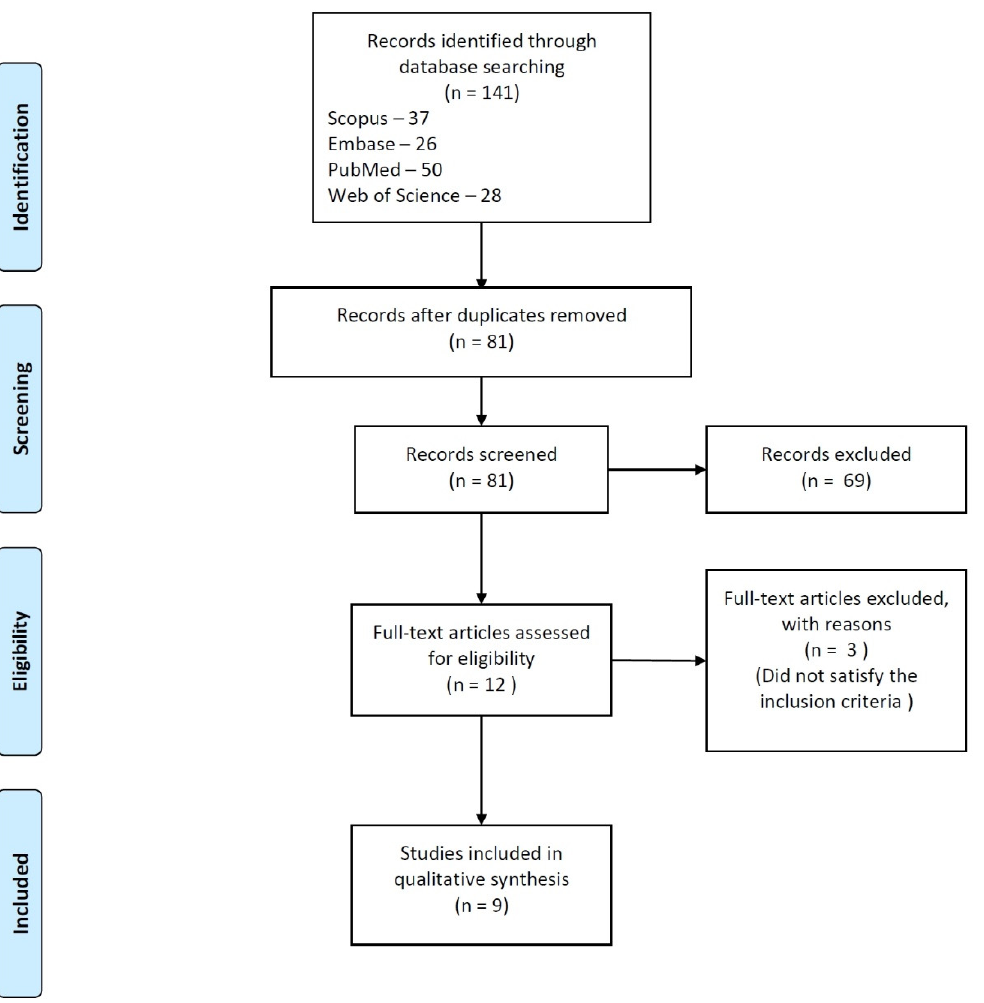
Figure 1. Summary of the workflow .